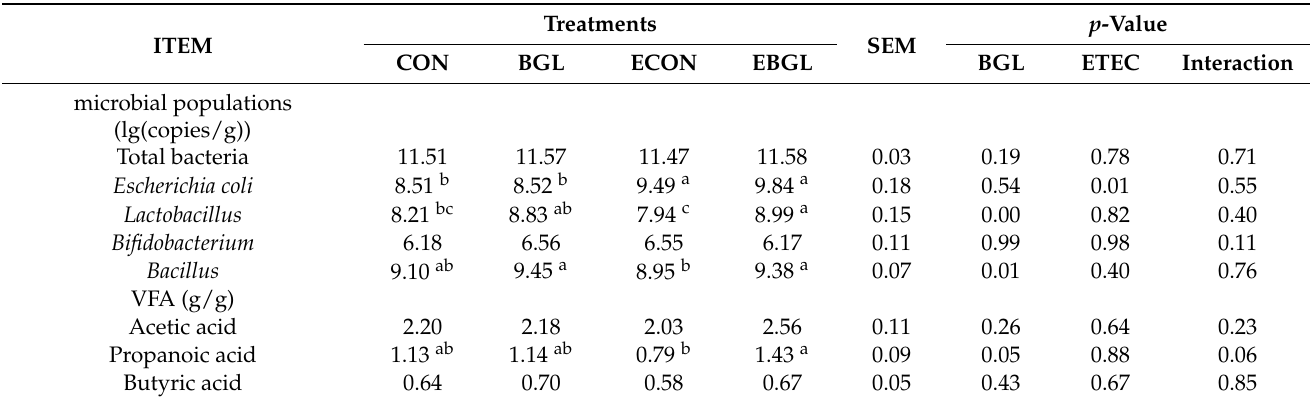
Table 3. Effect of BGL supplementation on intestinal microbiota and metabolites in weaned pigs upon ETEC